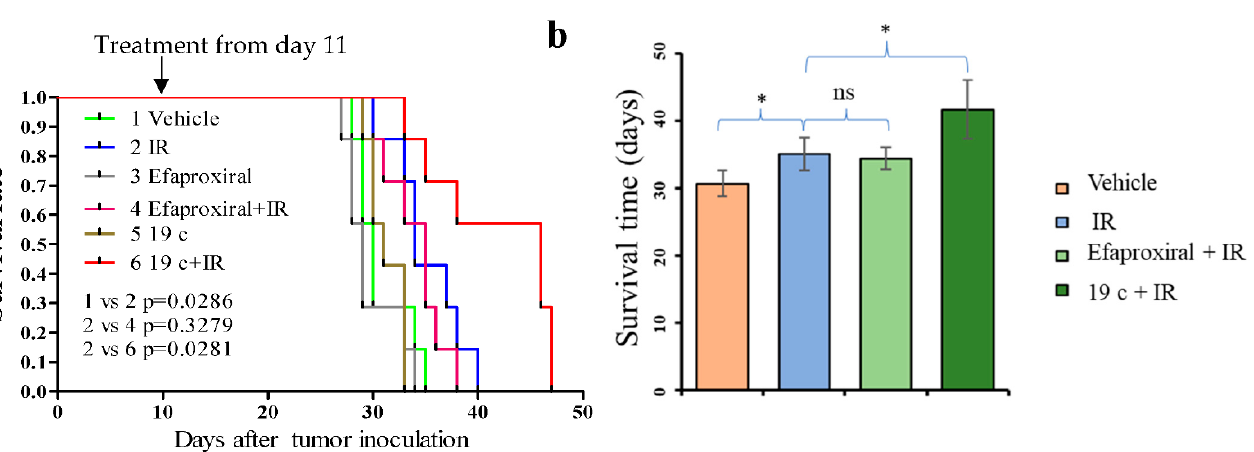
Figure 7. Compound 19c combined with radiotherapy is more effective than IR alone in extending animal survival. ( a , b ) Survival curves and survival extension of mice bearing GB xenografts. Statis- tical analysis was performed by unpaired Student’s t -test for two-group comparison. Data are means ± SD, n = 7, * p < 0.05.